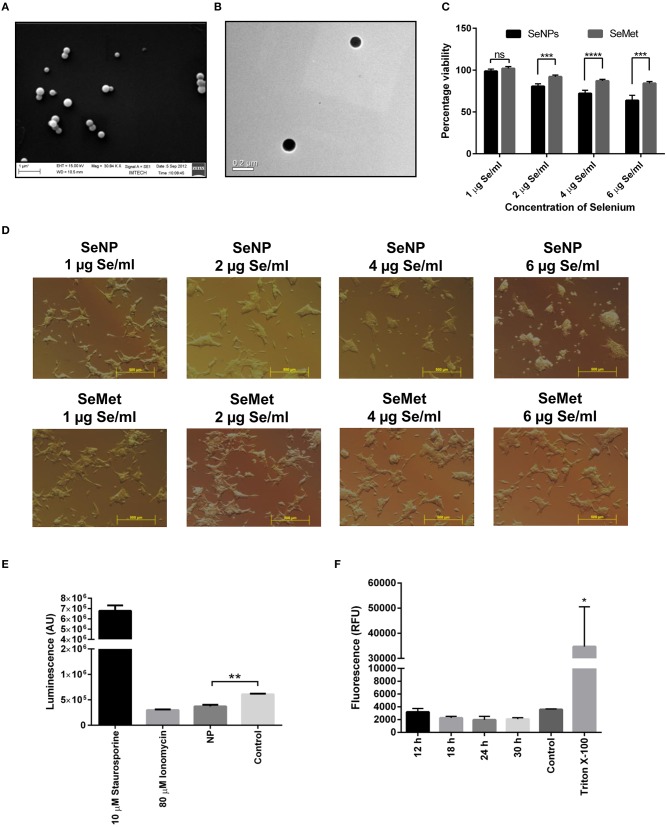
Effects on LNCaP cell viability upon treatment with different concentrations of SeNP or SeMet. (A) SEM and (B) TEM images of extracted and purified biogenic SeNPs from Bacillus licheniformis JS2 strain. (C) XTT assay showing the percentage viability of LNCaP cells after 24 h treatment with SeNPs or SeMet at a concentration of 1, 2, 4, and 6 μg Se/ml with respect to the untreated cells. A significant decrease in the cell viability of SeNP treated cells was observed compared to the SeMet treated cells with ***p < 0.001 and ****p < 0.0001 at concentrations of 2 μg Se/ml and above. The decrease in the cell viability at 2, 4, and 6 μg Se/ml SeNP was also statically significant with **p-value < 0.01 compared to 1 μg Se/ml SeNP. The experiment was conducted in triplicates. (D) Bright field microscopy images were taken at 40 X magnification representing the morphological changes in LNCaP cells after 24 h of treatment with SeNP or SeMet at selenium concentrations of 0–6 μg/ml. (E) Caspase-3/7 activity was measured in LNCaP cells treated with 2 μg Se/ml SeNP by using ApoTox-Glo assay kit containing a luminogenic caspase-3/7 substrate. The measurement is based on the caspases mediated cleavage of the substrate resulting in a “glow-type” luminescent signal. The amount of luminescent signal is proportional to the caspases activity in the cells. The experiment was performed in triplicate. **p < 0.01 indicates a significant difference in the caspase-3/7 activity between SeNP treated and untreated LNCaP cells. (F) Cells treated for 6, 12, 18, 24, and 30 h with 2 μg Se/ml SeNPs showed no release of LDH in the culture medium compared to the PBS treated cells (negative control). Cells treated with Triton-X 100 were taken as positive control. The experiment was performed in triplicate. *p < 0.05 represents a significant difference between the LDH release from the positive control and SeNP treated cells.